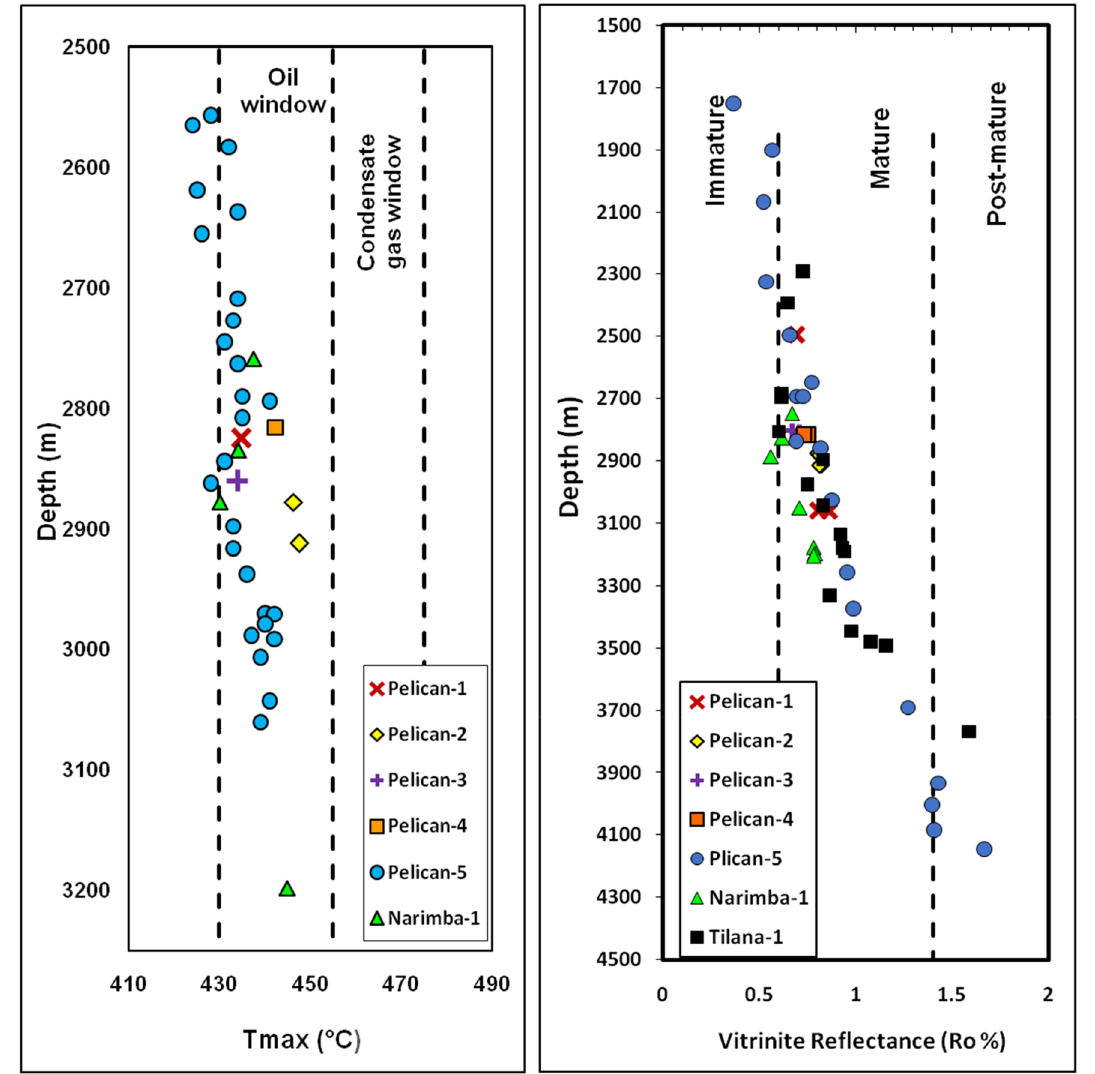
Fig. 12 T max and vitrinite reflectance versus depth showing the trend of maturity levels with